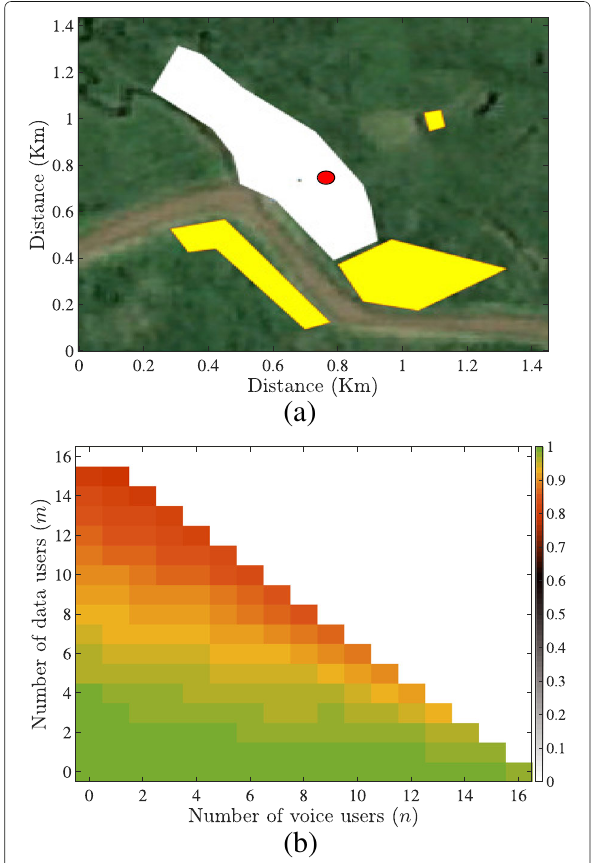
Fig. 6 Traffic intensity distribution and coverage probability. a Traffic intensity. Traffic intensity in yellow areas corresponds to half the intensity in white areas. The traffic intensity in green areas is considered negligible. The absolute values of the generated traffic depend on the time instant and the year, as explained in the paper and illustrated through numerical examples in the simulations section. b Coverage probability of being able to attend n voice and m data users simultaneously, in other words, probability that there is enough transmit power to be able to attend this number of connections simultaneously. This probability depends on the spatial distribution of users according to figure above. The colors refer to the values of this probability according to the right vertical colorbar